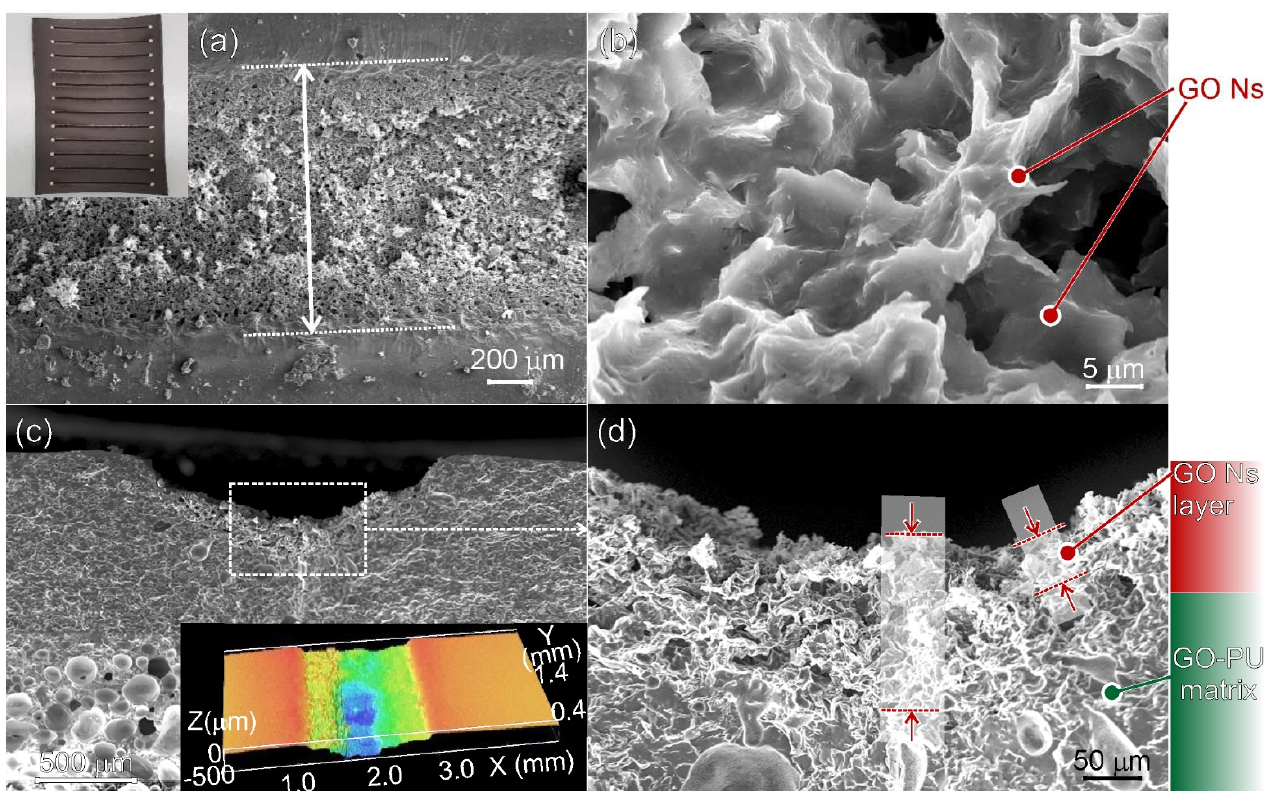
Figure 5. SEM images of a laser-irradiated path: ( a ) low- and ( b ) high-magnification top-view images; ( c ) low- and ( d ) high-magnification cross-sectional views. In the insets of ( a , c ), a picture of the irradiated paths and an optical 3D profilometry image of the path are illustrated.